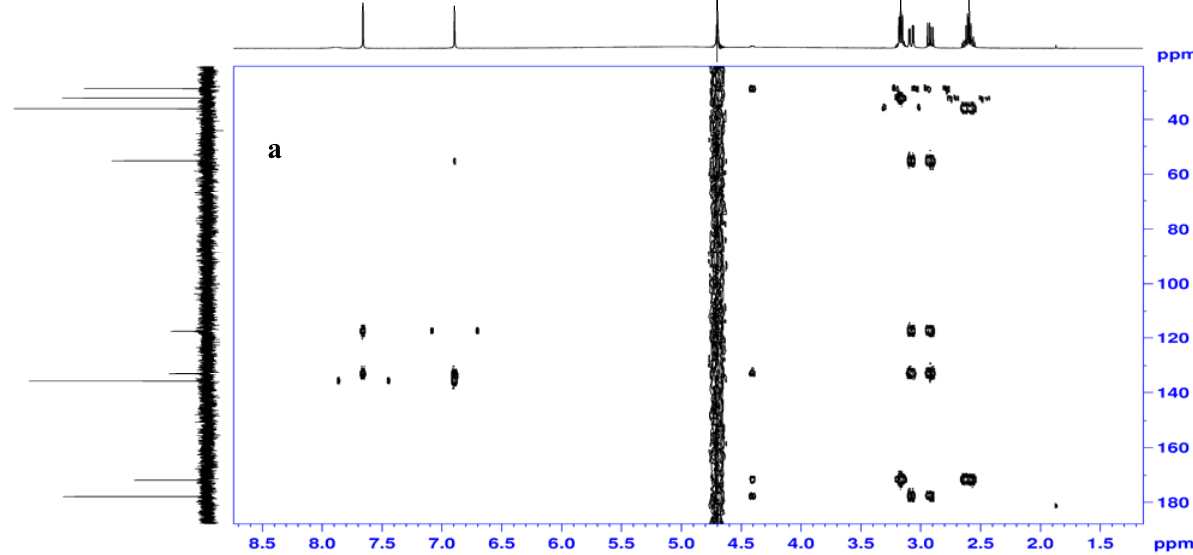
Figure 7. 1 H- 13 C-NMR correlation (gHMBC) spectra for L -carnosine ( a ) and Ru-carnosine complex ( b ).